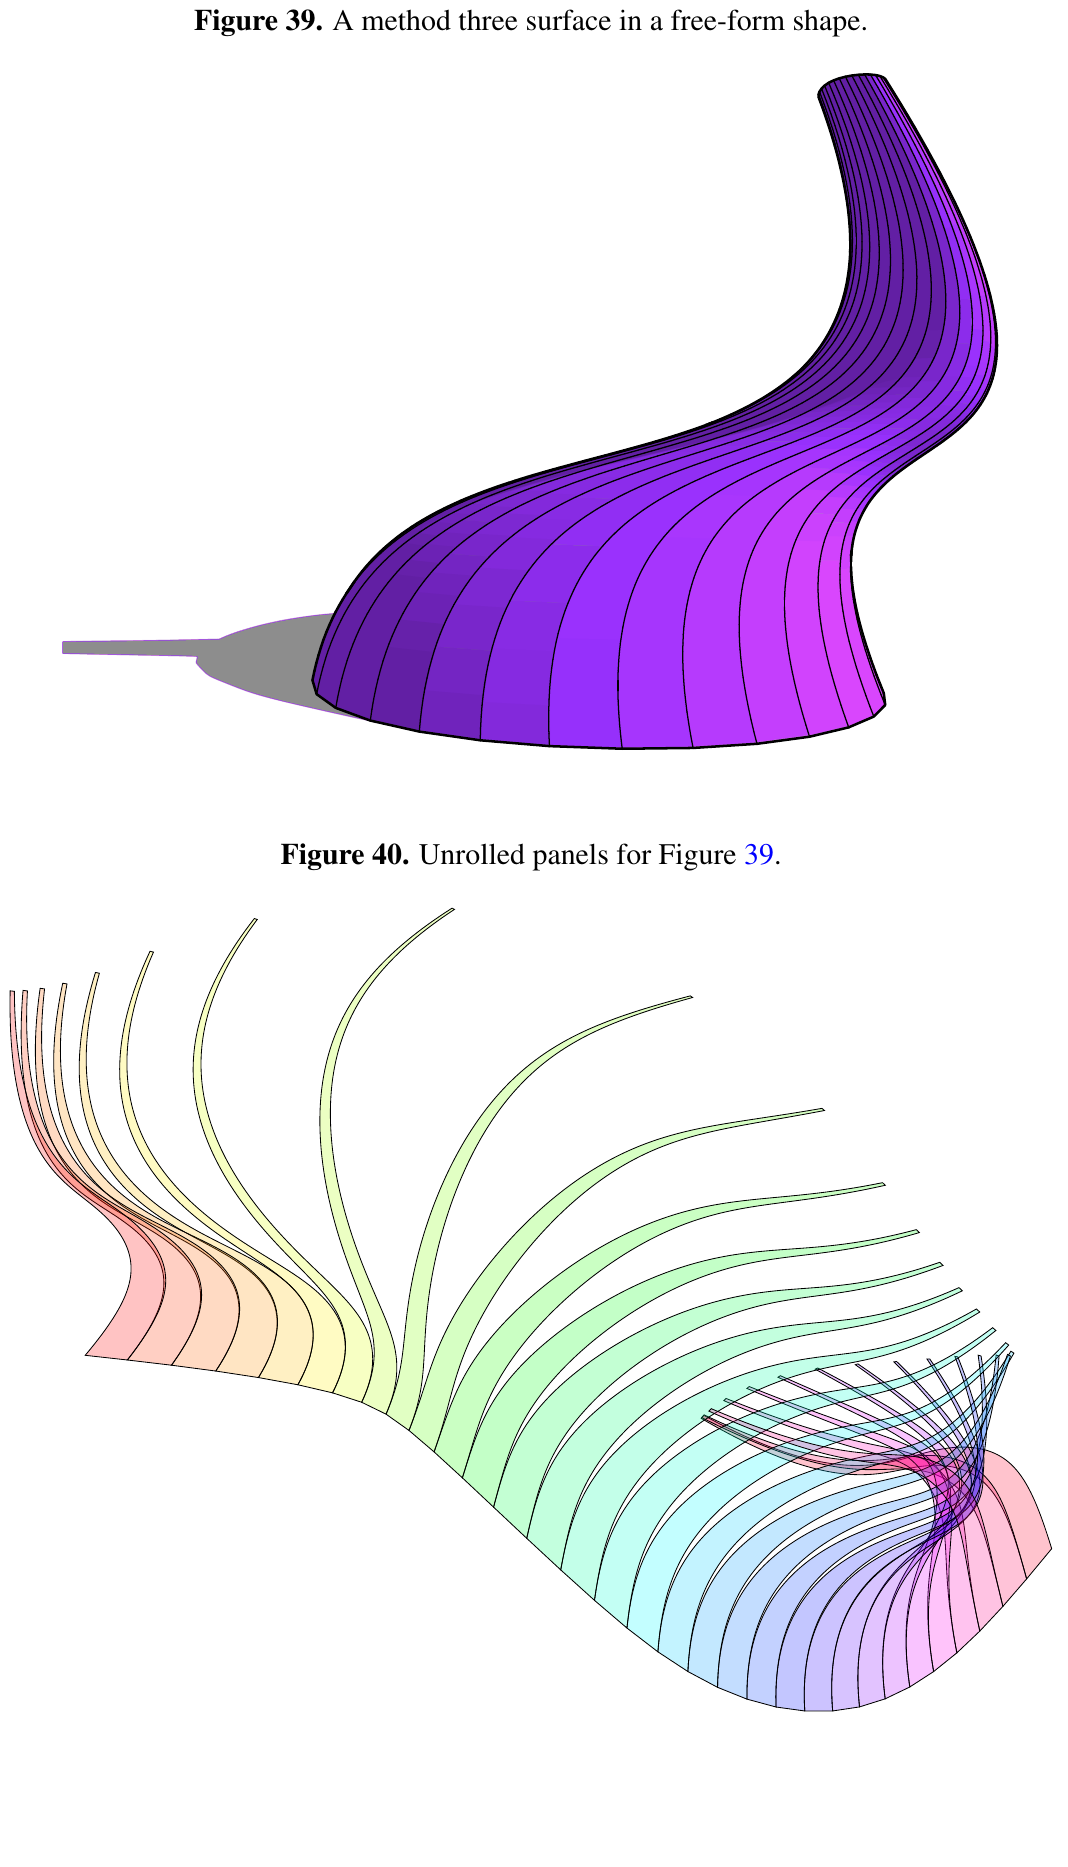
Figure 39. A method three surface in a free-form shape.